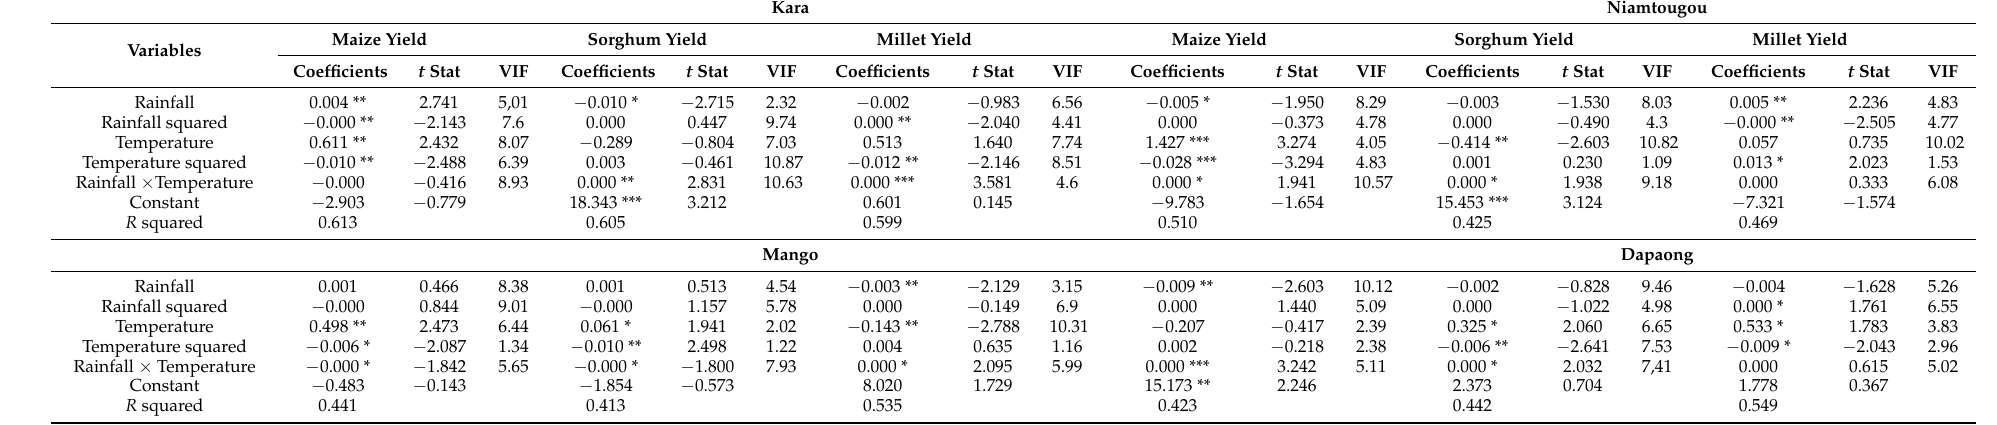
Table 9. Multiple regression analysis between crop yields, rainfall and temperature during growing season in Kara, Niamtougou, Mango and Dapaong.